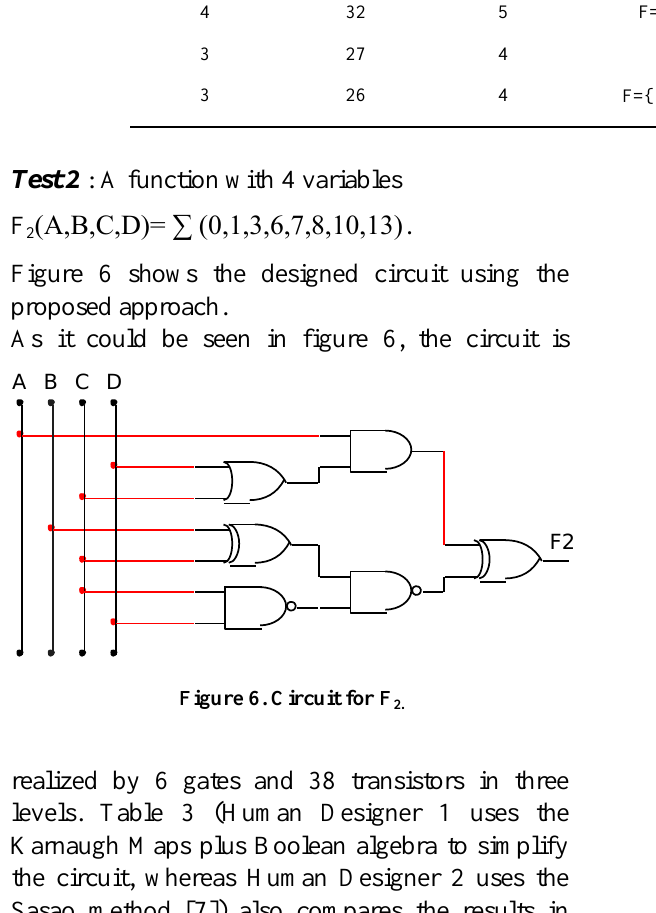
Figure 7. Convergence diagrams for function F 2